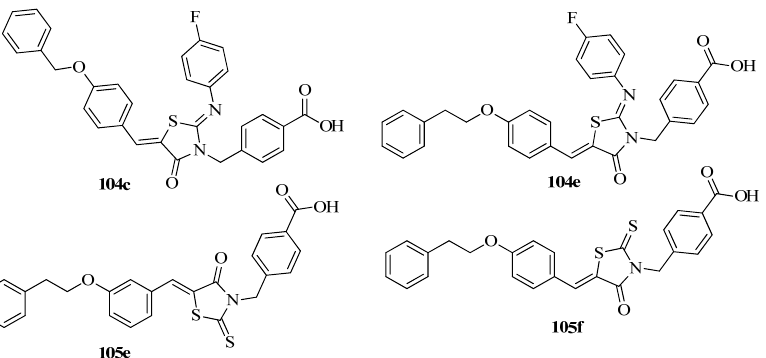
Figure 41. Structures of {[5-arylidene-2-(4-fluorophenylimino)-4-oxothiazolidin-3-yl]methyl}benzoic acids (5) and 2-thioxo-4-thiazolidinone analogues. That same year, Meng et al. [159] synthesized a series of 2-imino-3-substituted-5-heteroarylidene-1,3-thiazolidine-4-one derivatives as possible PTP1B inhibitors. It was found that substitution by pyrrole groups at the 5-position of the 1,3-thiazolidine-4-one was more beneficial than that of the compounds with the substituted pyridine groups on the same position. Thus, compounds 106b , 106h , and 106i (Figure 42) exhibited good activity against PTP1B among which compound 106i was the most active with an IC 50 of 6.37 µ M. This compound can be considered as the lead for further modifications.